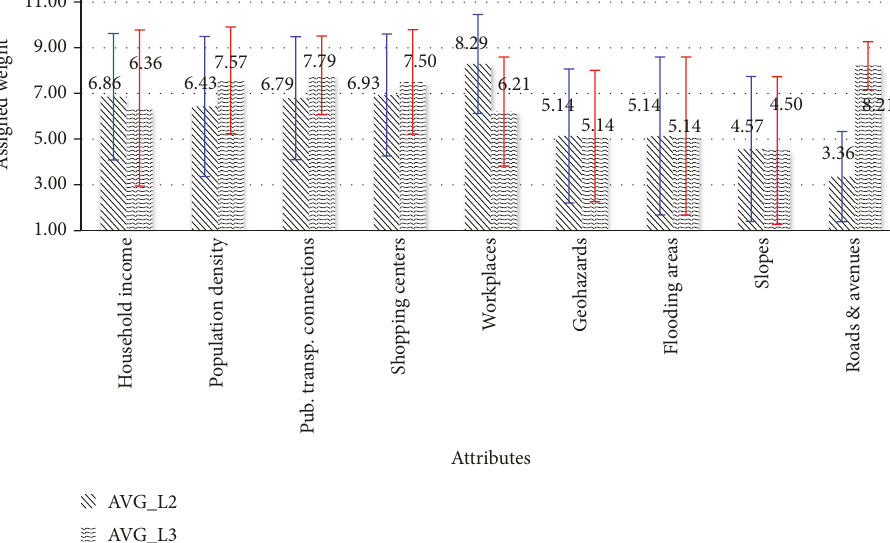
Figure 3: Average rating of expert rated attributes and standard deviation.